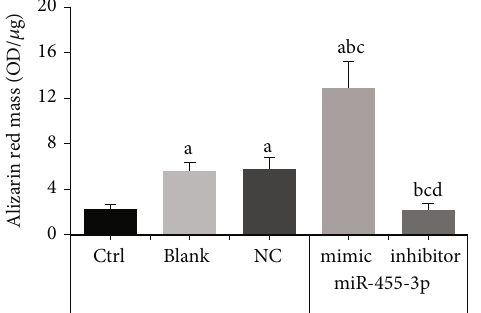
Figure 4: Detection of alizarin red mineralization staining in BMSCs. Note: A, B, C, and D meant P < 0 : 05 in comparison to the Ctrl, blank, NC, and mimic groups, respectively.